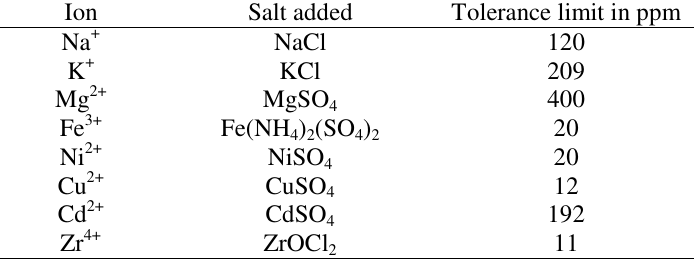
Table 3. Effect of foreign ions on the determination of